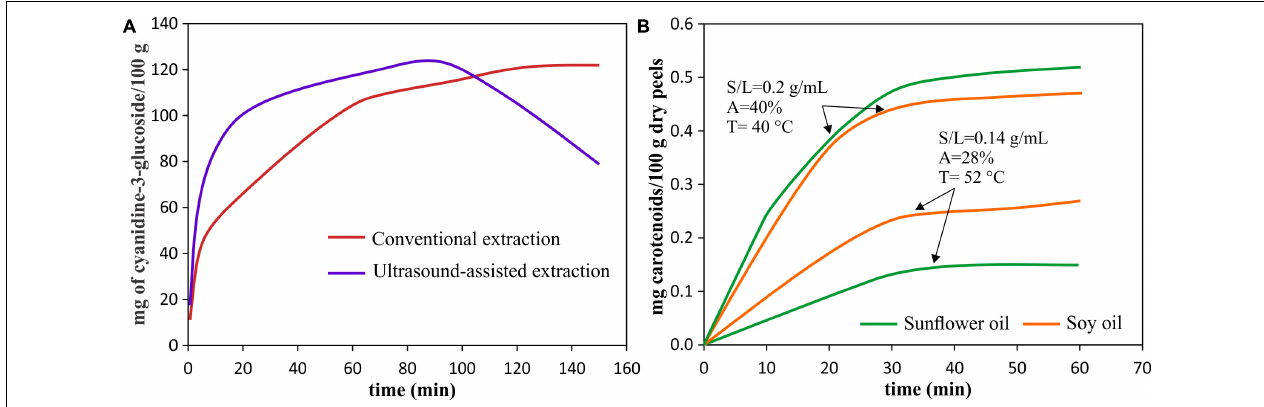
FIGURE 4 | Pigment extraction kinetics. (A) Extraction kinetics of anthocyanins from red araçá peel by using UAE [40 ◦ C, 40 kHz, 154 W, S/L = 0.2 g/mL] and conventional extraction (90% (v/v) ethanol with 0.1% HCl), data from Meregalli et al. (56). (B) Extraction kinetics of carotenoids from pomegranate peels for different UAE conditions: solvents, amplitude (A), temperature (T), and solid-liquid (S/L) ratio, data from Goula et al.